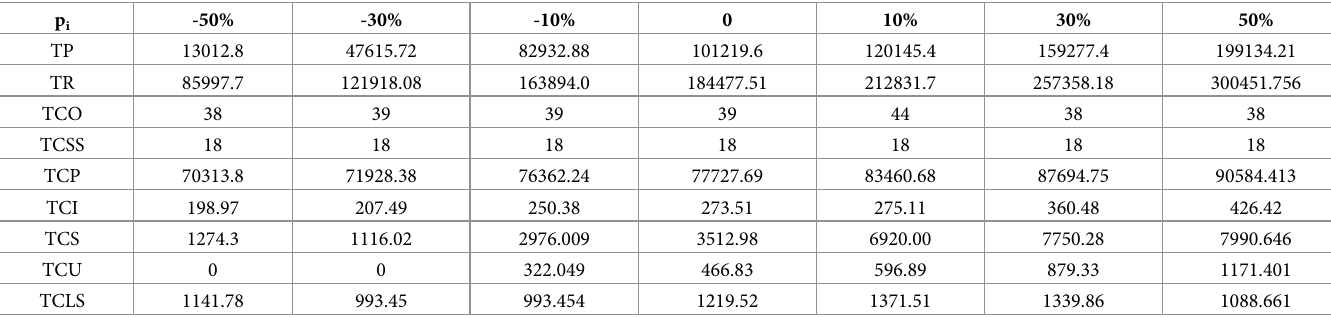
Table 6. The changes in the costs and sales profits due to the changes in the